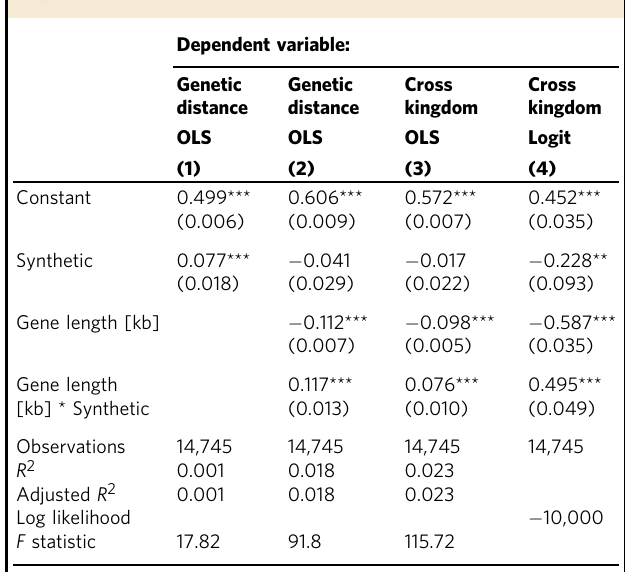
Table 1 Regression results comparing natural and synthetic sequences from the Addgene